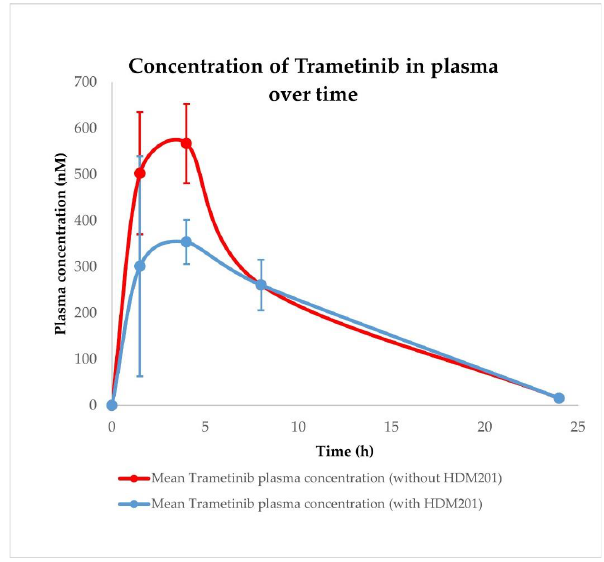
Figure 6. Pharmacokinetic profiles of Trametinib in plasma after administration with and without HDM201. Observed data are means ± standard deviation (SD) from n = 3.